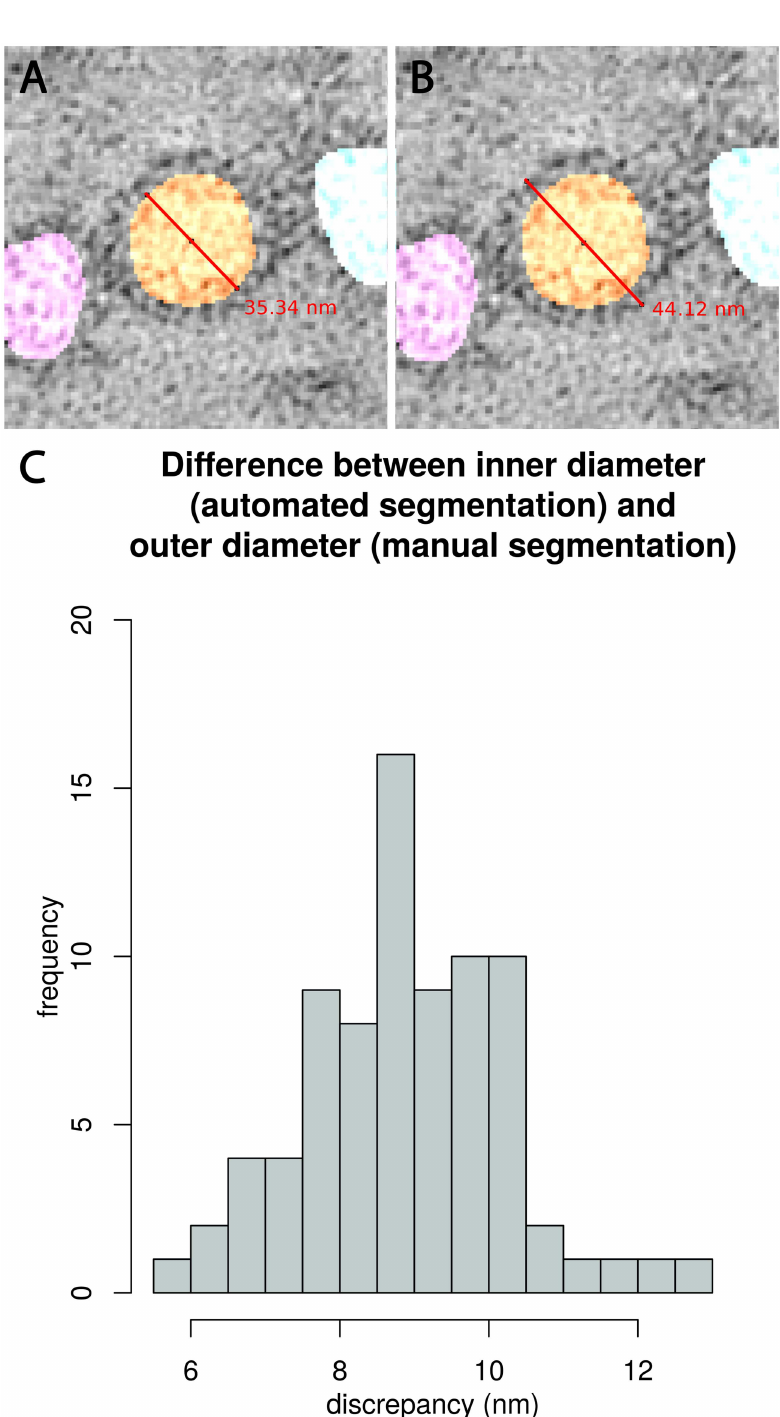
Fig 3. Measurement of inner and outer synaptic vesicle diameter. In order to get an approximate value of the discrepancies betweenvesicle diametersof manual and automatedmeasurement we appliedthe Fiji measurement tool. Fig 3 (A) shows the inner diameterof a vesicle that was annotated by 3D ART VeSElecT, (B) shows the outer diameter. Fig 3 (C) gives the results of the discrepancy of inner and outer diameter of all measuredvesicles shownas a histogram(number of measurements =